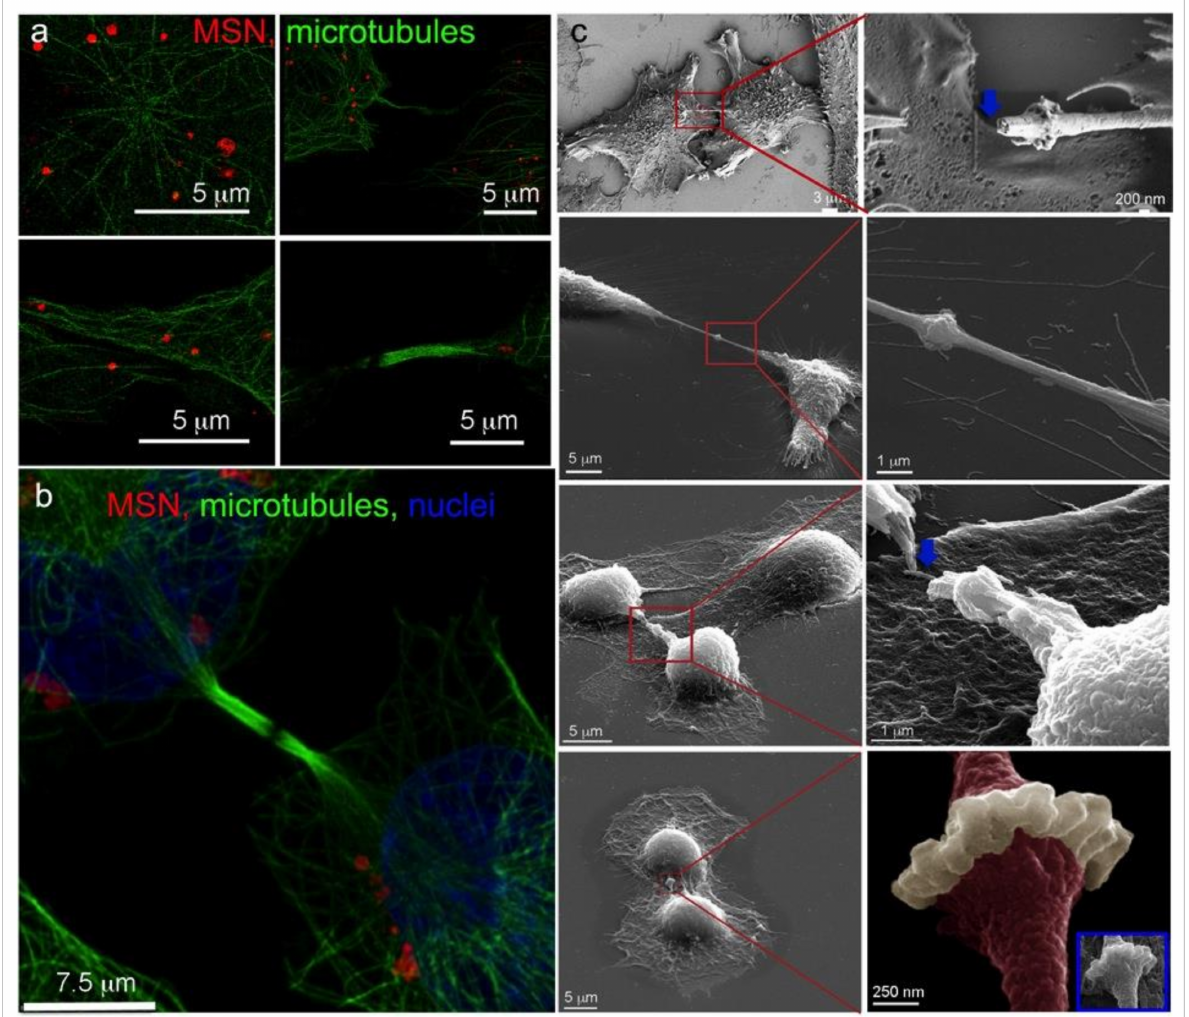
Figure 6. Super-resolution and topographic imaging of mitotic bridges. ( a ) Sequential super- resolution (dSTORM) labeling and imaging of HeLa cells incubated with DyLight 633-labeled MSN (red) for 5 h at 37 ◦ C and mouse anti-human alpha tubulin AF488 (green). ( b ) HyVolution deconvo- luted fluorescent confocal microscopy image of microtubule-rich (green) mitotic bridges following 24 h incubation with DyLight 633-labeled MSN (red; nuclei labeled with DAPI and shown in blue). ( c ) Scanning electron micrographs of four telophase HeLa cells with midbody regions amplified as indicated by red boxes. Arrows (blue) indicate procedural breaks in nanotubes. The final midbody image is false-colored red with the original grayscale image presented in the